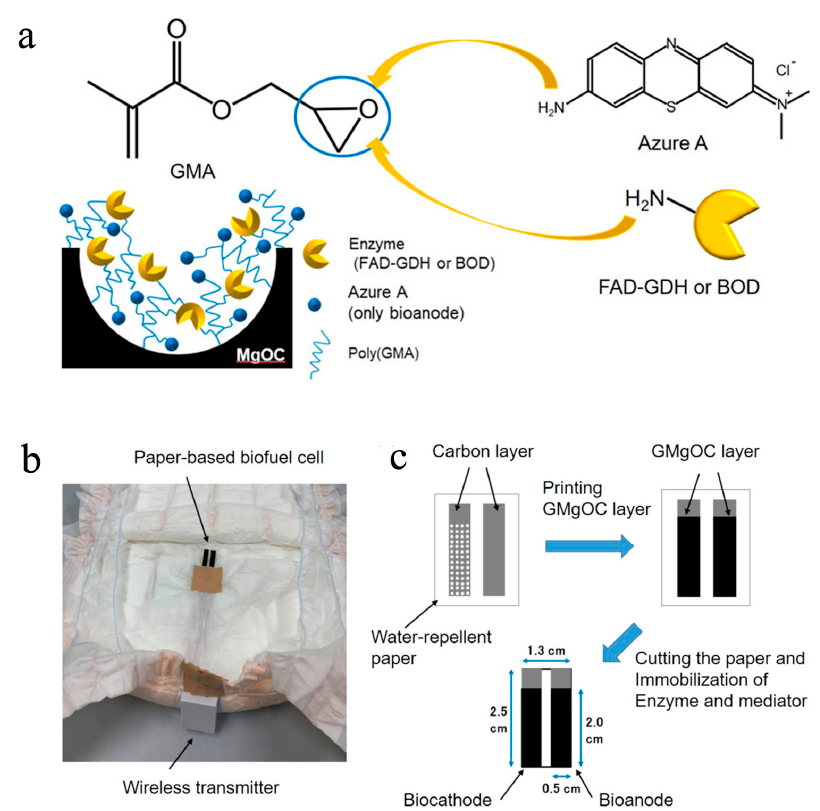
Figure 7. ( a ) Schematic diagram of the MgO-templated electrode in the diaper sensor. The FAD-dependent glucose dehydrogenase (FAD-GDH) and azure A were used as the anodic catalyst and electron-mediator, respectively; Digital photo of the self-powered diaper sensor connected to a wireless transmitter ( b ) and its fabrication process ( c ) [48]. Copyright 2021 American Chemical Society.